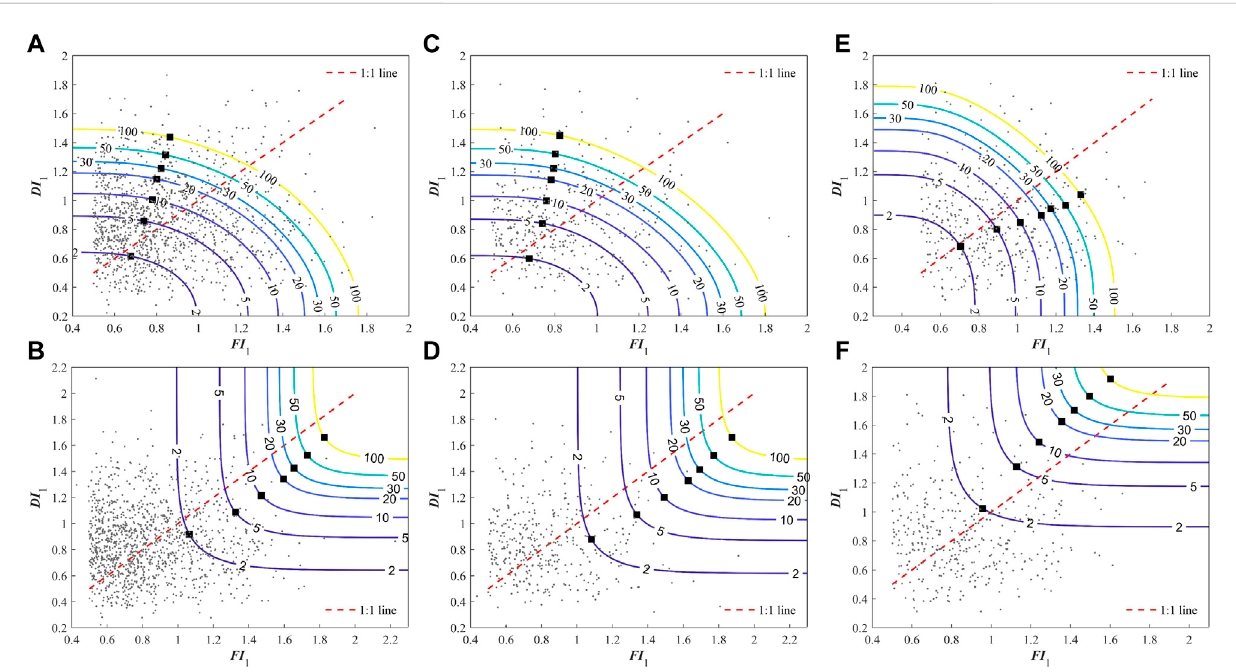
FIGURE 10 Isolines and MLCs of DI 1 and FI 1 for three sub-basins in the HRB. The squares denote MLC (( fi *, di *) while the small black dots are the identi fi ed DTF events: (A ) The AND case in UB; (B) The OR case in UB; (C) The AND case in MB; (D) The OR case in MB; (E) The AND case in LB; (F) The OR case in